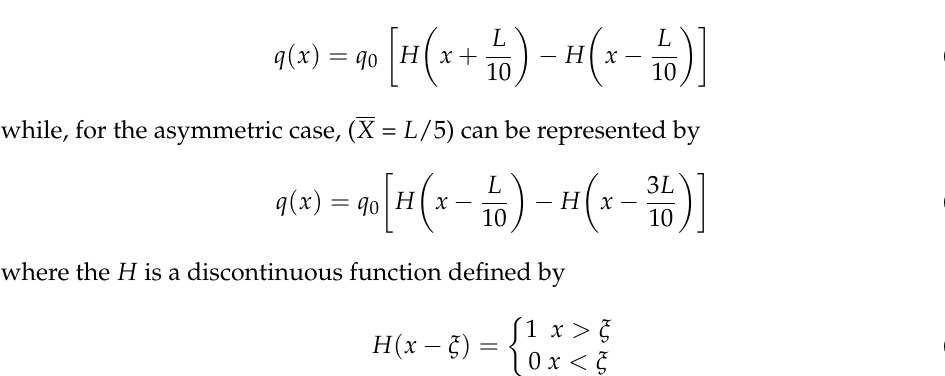
Table 1. The numerical data for Example 1. Item Value Elastic modulus of the beam material ( E ) 25 GPa Subgrade reaction modulus ( k ) 20,000 kN/m 2 Beam length ( L ) 12.0 m Depth of the beam cross-section ( h ) 0.40 m Width of the beam cross-section ( b ) 0.60 m The patched load q 0 400 kN/m